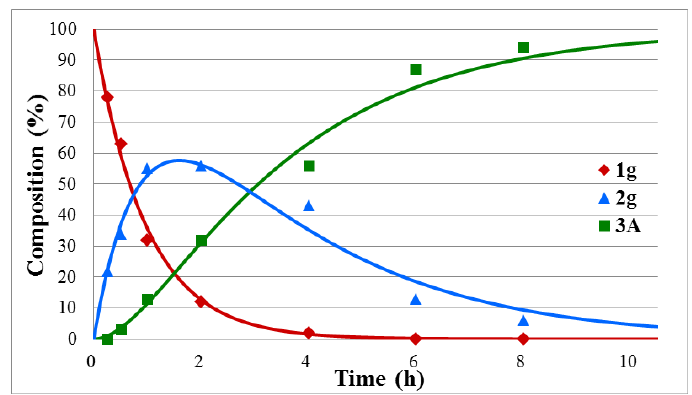
Figure 2. Concentration profile for the components during the hydrolysis of diethyl α-hydroxybenzylphosphonate ( 1g ) under optimum conditions. The R 2 measure of goodness of fit is 0.986.